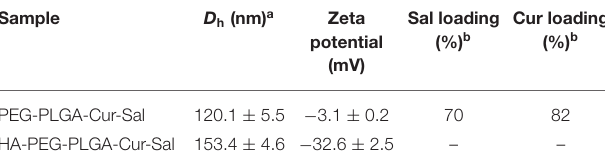
TABLE 1 | Hydrodynamic size and drug loading of the